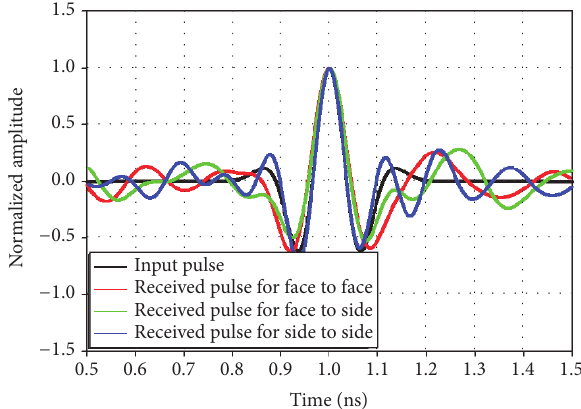
Figure 8: Comparison of input and received pulses of the proposed antenna for different orientations.